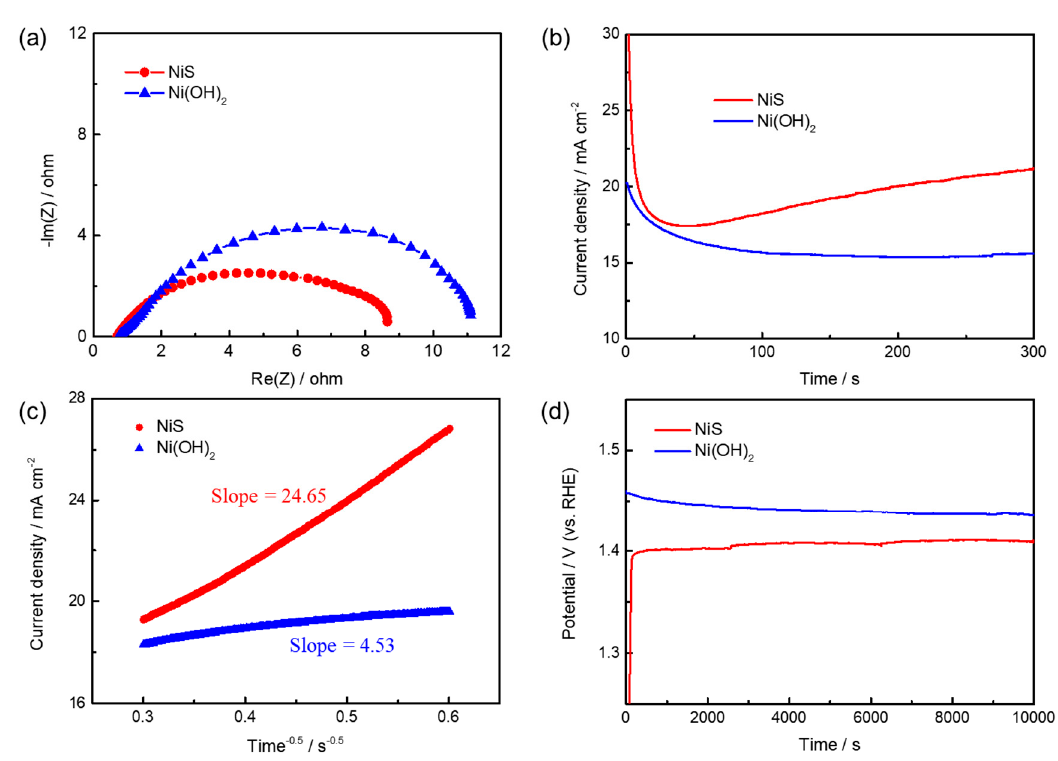
Figure 5. ( a ) Nyquist plots of NiS and Ni(OH) 2 measured at onset potential; ( b ) chronoamperometry plot of NiS and Ni(OH) 2 measured at 1.42 V; ( c ) dependence of current on the time-0.5 derived from ( b ); ( d ) stability test of NiS measured at the current density of 10 mA cm − 2 in 1 M KOH with 0.33 M urea.